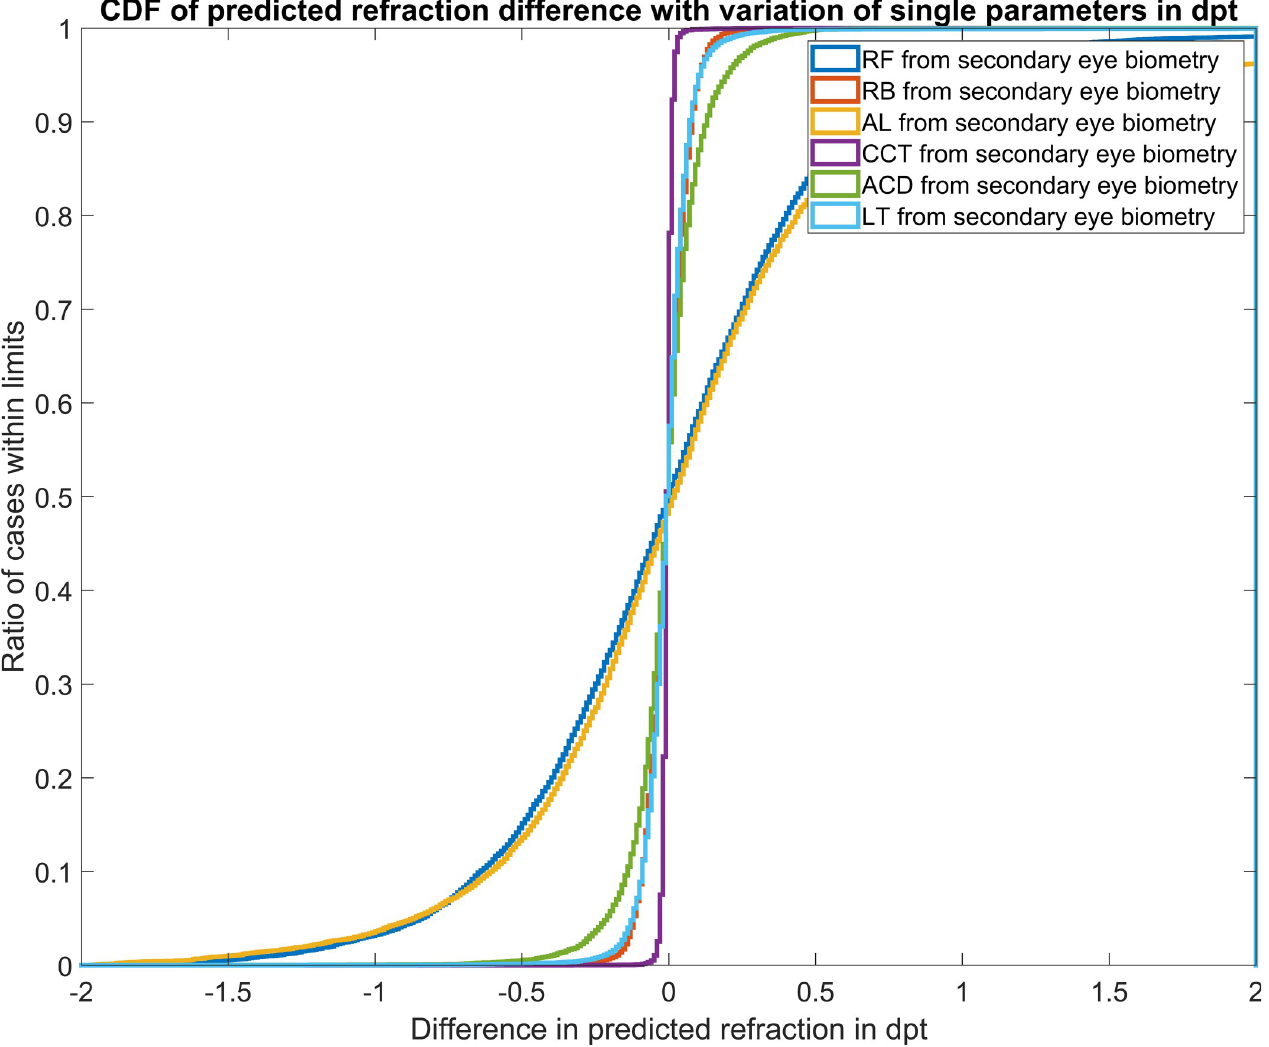
Fig 4. Cumulative density function (CDF) for the predicted refraction if–instead of using all parameters from the fellow eye– only one biometric parameter from the fellow eye (secondary eye) is used to calculate the intraocular lens power. From this lens power we back-traced the predicted refraction at the spectacle plane. RF / RB / AL / CCT / ACD / LT from secondary eye biometry refers to the situation where only the corneal front surface curvature /corneal back surface curvature / axial length / central corneal thickness / anterior chamber depth / the thickness of the crystalline lens is replaced in the lens power calculation by the respective value from the secondary